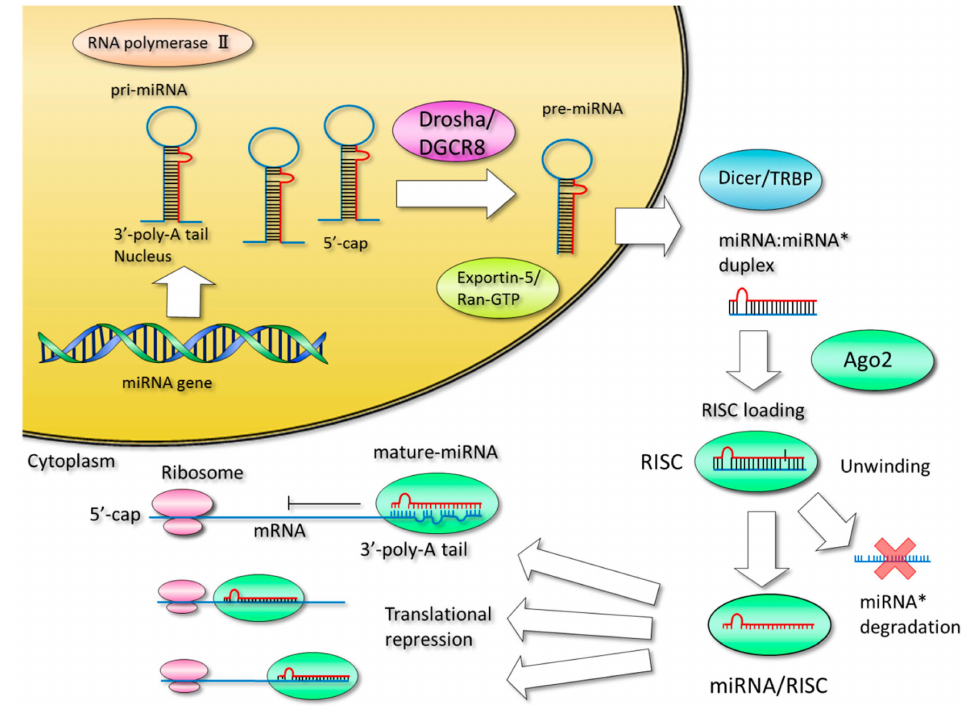
Figure 1. MicroRNA synthesis and function. MicroRNA genes are transcribed by RNA polymerase II to produce primary microRNAs (pri-microRNAs) and cleaved by Drosha/DGCR8 into pre-microRNAs. Pre-microRNAs are exported from the nucleus by exportin-5 and Ran-GTP, and then the hairpin is cleaved by Dicer/TRBP in the cytoplasm. The microRNA duplex is unwound and one strand is complexed with argonuate 2 (AGO2) to form the RNA-induced silencing complex (RISC), and the unused passenger strand (miRNA*) is degraded. The microRNA guides the RISC to a partially complementary target region in the 3 1 untranslated regions of one or more genes, resulting in translational repression or target cleavage. Distinct proteins or protein complexes are depicted as colored ovals. Red and blue lines indicate